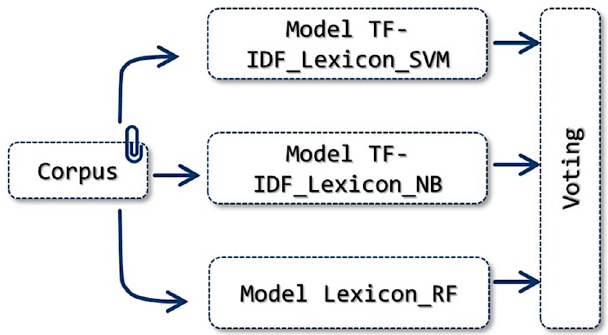
Figure 10. TF-IDF_Lexicon_E_Clfs Model.